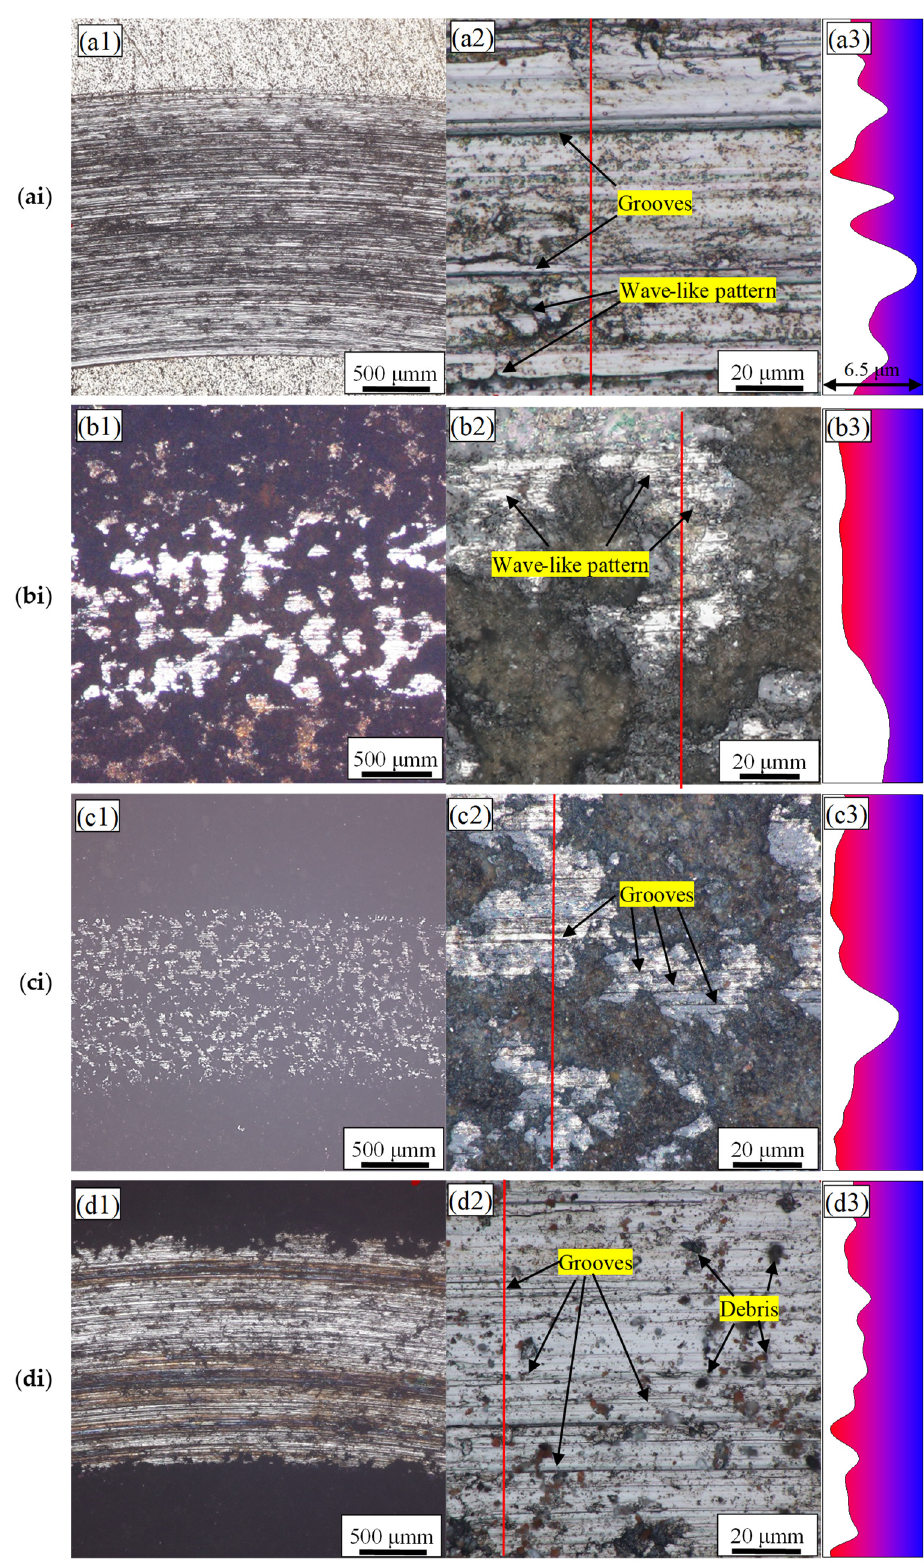
Figure 6. Wear trace and profile graphs of specimens: ( ai ) substrate, ( bi ) A20V, ( ci ) A40V, and ( di ) A60V; x1 (x = a, b, c, d) is the worn trace, x2 (x = a, b, c, d) is the enlarged worn trace image, x3 (x = a, b, c, d) is the profile graph of the corresponding specimen